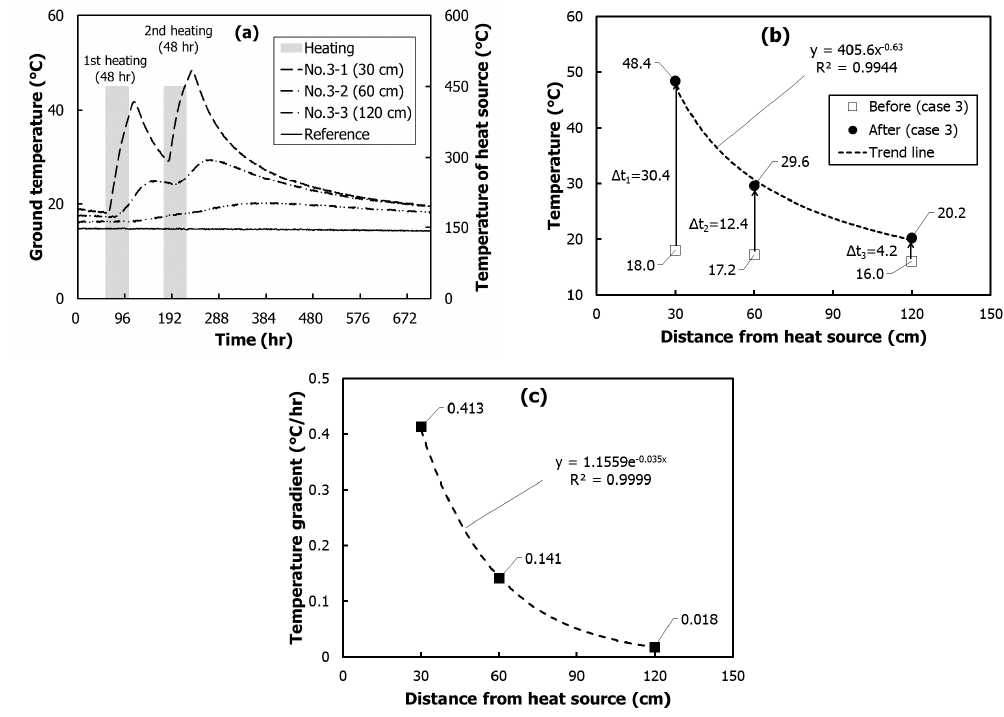
Figure 8. The temperature variation by ground heating using an electric heat pipe. ( a ) The temperature variation of all the sensors; ( b ) the variation of the temperature curve; ( c ) the temperature gradient according to the distance from the surface of the electric heat pipe. Table 2. The temperature variation due to ground heating (Case 3).